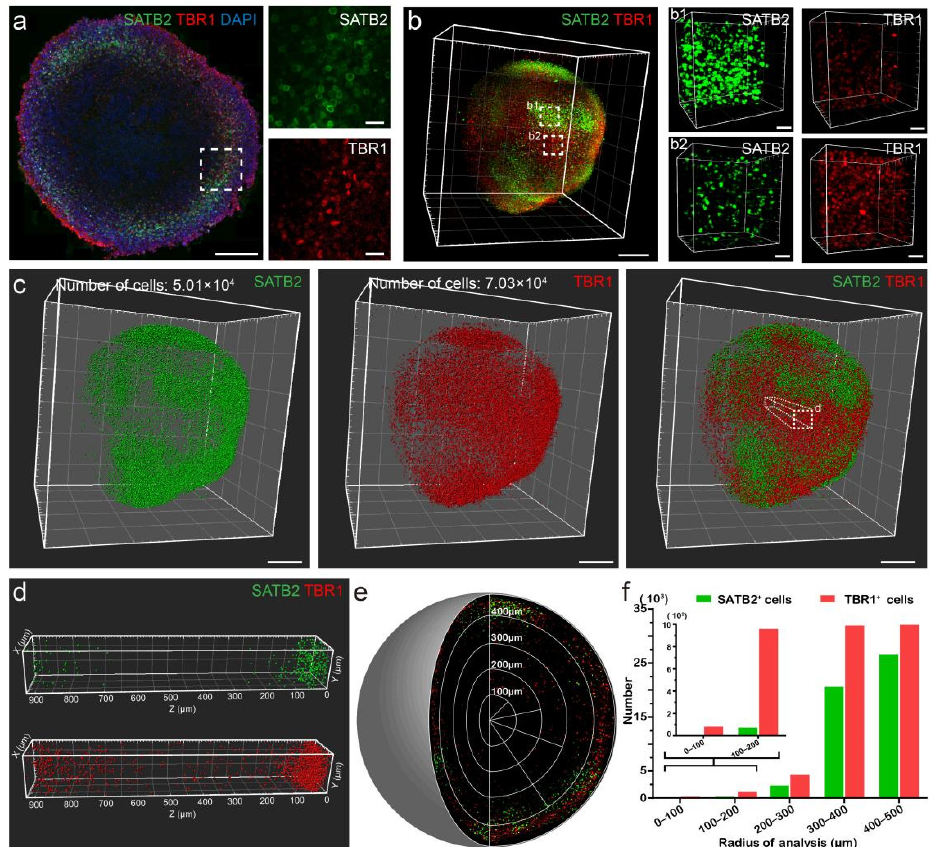
Figure 5. Distribution of cortical layer markers in organoids. ( a ) Maximum intensity z-projections of 100- μ m-thick sections of a cerebral organoid imaged by confocal microscopy. Scale bar: 200 μ m (left); 25 μ m (right). ( b ) Three-dimensional view shows the spatial distribution of SATB2 + and TBR1 + cells in a whole organoid. ( b1 , b2 ) Higher magnifications of specified regions in b. Scale bars: 200 μ m (left); 50 μ m (right). ( c ) Spot analysis showing the number of SATB2 + and TBR1 + cells. Scale bars: 200 μ m. ( d ) Sample volume from ( c ) showing details on the distribution of SATB2 + and TBR1 + cells along the radius of the organoid. ( e ) Distribution of SATB2 + and TBR1 + cells within the organoid. ( f ) Graph showing the spatial distribution of SATB2 + and TBR1 + cells, illustrating increased cell density toward the periphery of organoids. In this figure, the red fluorescent signals denoted TBR1 + cells, and the green fluorescent signals denoted SATB2 + cells.